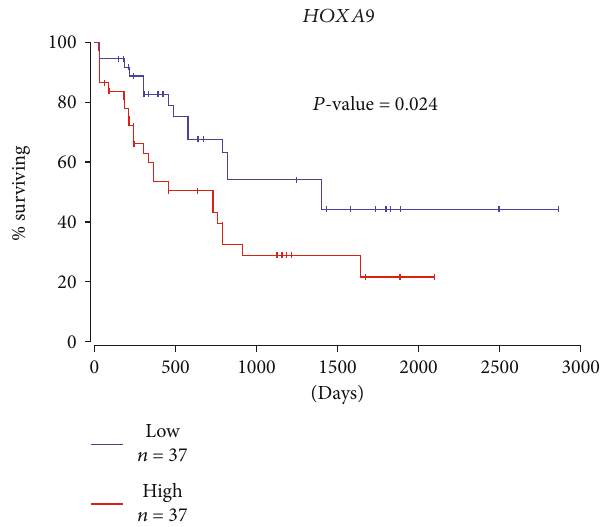
Figure 9: Overall survival analysis for HOXA9 in acute myeloid leukemia. Kaplan-Meier survival analysis of HOXA9 in acute myeloid leukemia (AML) using TCGA dataset. Survival analysis was performed for AML patients (total n = 74 ) with a cuto ff value of 25th percentile. Credits: